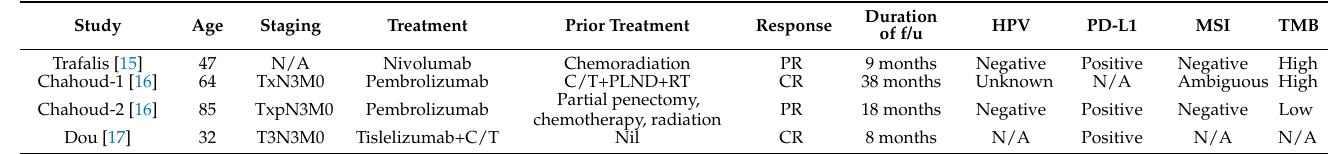
Table 1. Case reports of immunotherapy on advanced penile